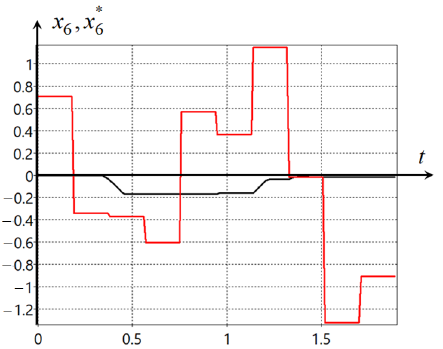
Figure A6. Plots of optimal x 6 and x 6 ∗ .